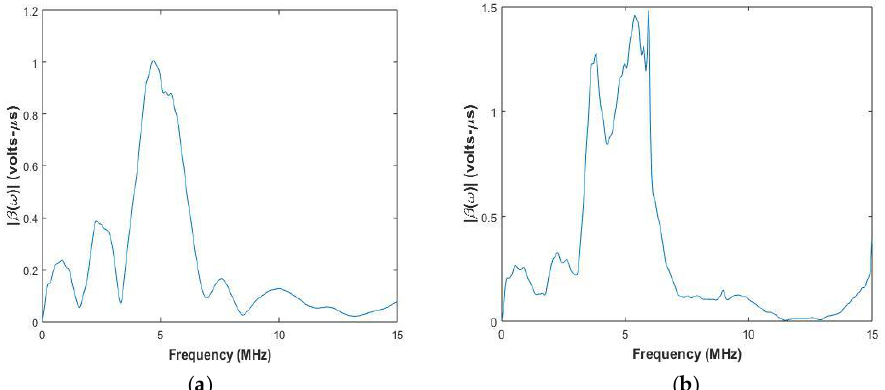
Figure 5. System function of pair of elements with center frequency of 5 MHz used for testing ( a ) Aluminium ( b ) CFRP laminate.